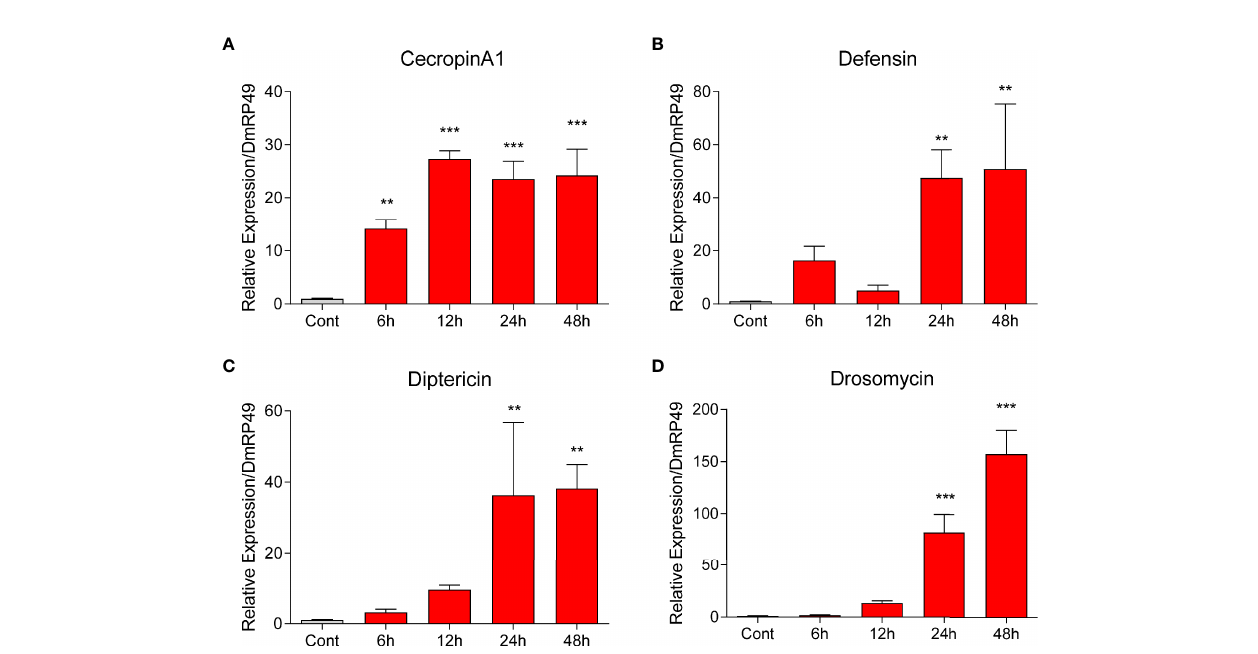
FIGURE 5 | NOC induced AMP expression in Drosophila S2 cells. The NOC at a fi nal concentration of 2.5 mM was used to treat S2 cells. Transcript levels of the four AMPs Cecropin A1 (A) , Defensin (B) , Diptericin (C) , and Drosomycin (D) at different time points were measured by qPCR. One-way ANOVA followed by Tukey ’ s test was used to compare control and treated groups. ** p < 0.01; *** p <